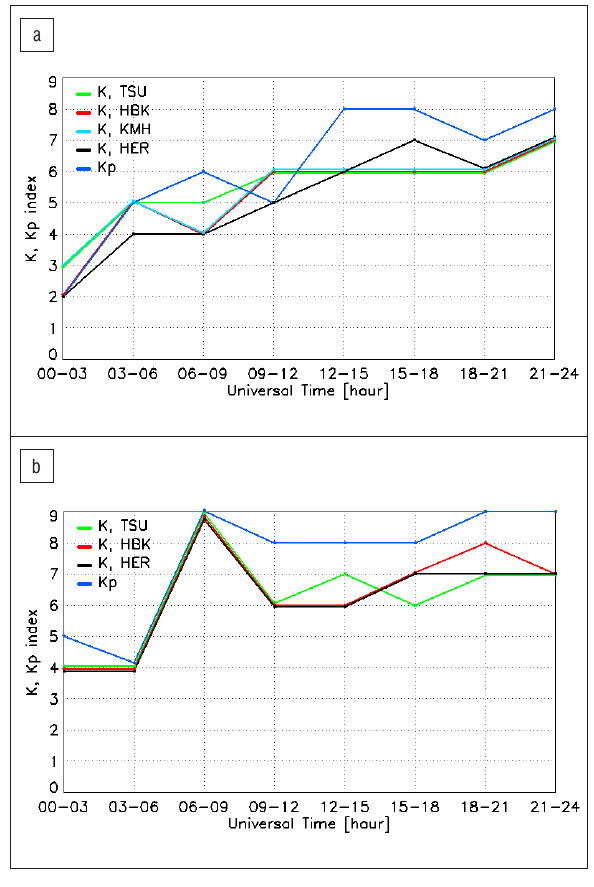
Figure 3: Comparison of geomagnetic local K-index at HER, HBK, TSU, KMH and global Kp-index for (a) Saint Patrick’s Day storm on 17 March 2015 and (b) Halloween magnetic storm on 29 October 2003. KMH started operating in 2006 and is therefore not represented in (b).